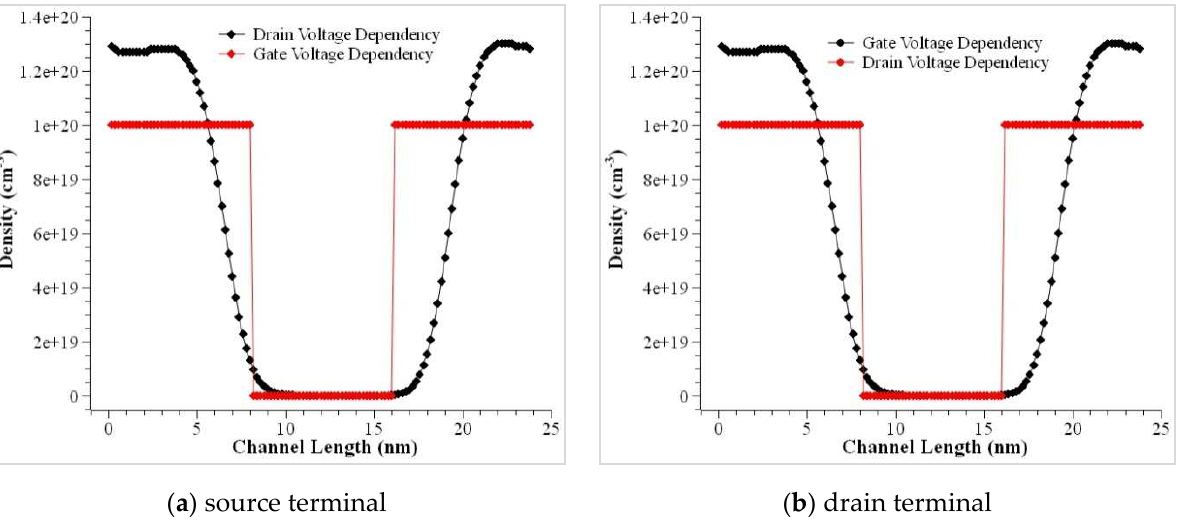
Figure 4. Electron density profile V D versus V G in the CSDG MOSFET. ( a ) source terminal, ( b ) drain terminal.